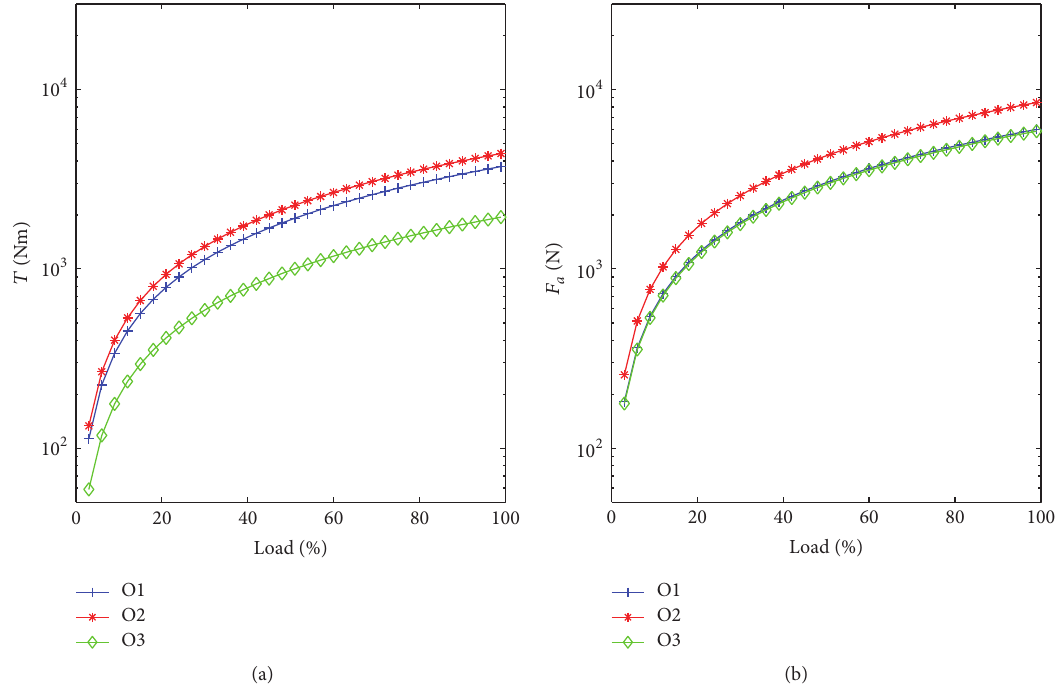
Figure 11: Effect of increasing workload on the three output shafts, (a) axial torque; (b) axial